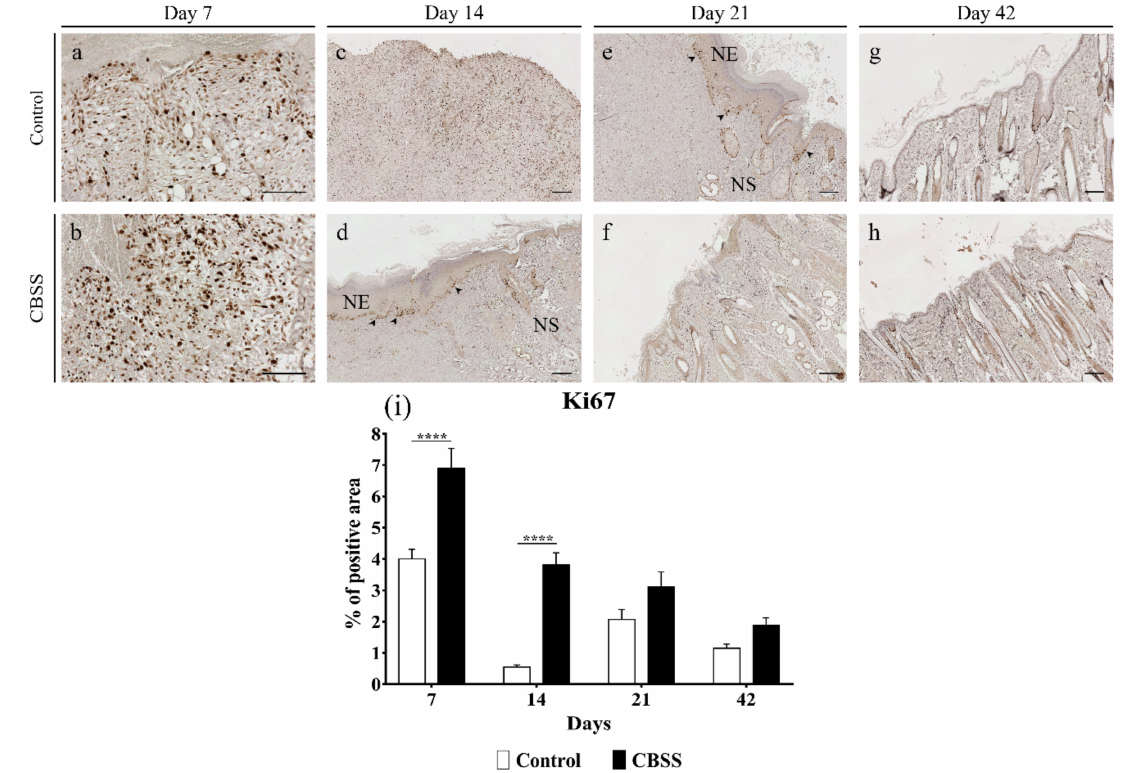
Figure 7. Immunohistochemistry microphotographs for Ki67 immunolabeling. Wounds are showed at ( a , b ) 7 days, ( c , d ) 14 days, ( e , f ) 21 days, and ( g , h ) 42 days. ( i ) Quantitative analysis of the percentage of positive area of each sample at 7, 14, 21, and 42 days. Arrowhead = active proliferating keratinocytes in the epidermal basal layer; NE = neoepidermis; NS = neoskin. Scalebar = 200 µ m. ( i ) Data are expressed as mean ± SEM. Statistical differences were measured between the two experimental groups at the same time-point. **** p <